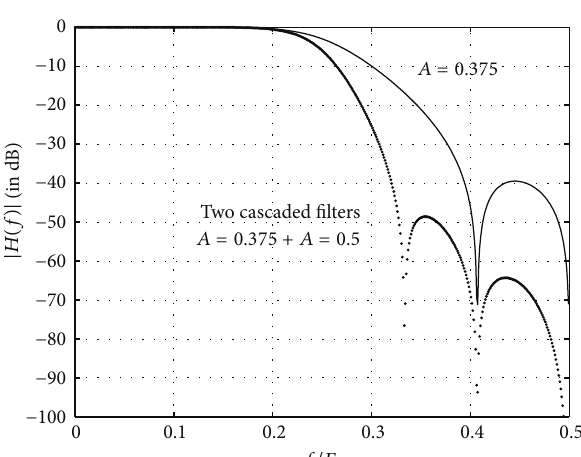
Figure 3: Half Band filter transfer function.